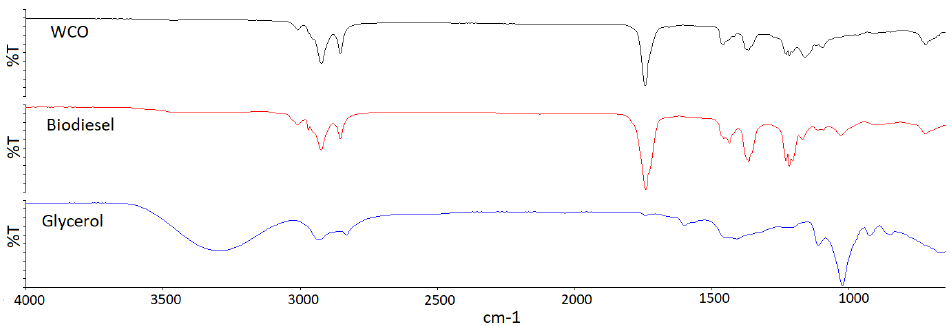
Figure 15. FT − IR spectrum of waste cooking oil in comparison to biodiesel and